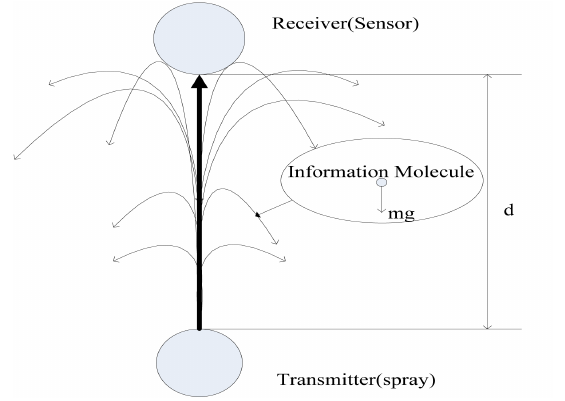
Figure 2: The sketch model of Molecular Commu-